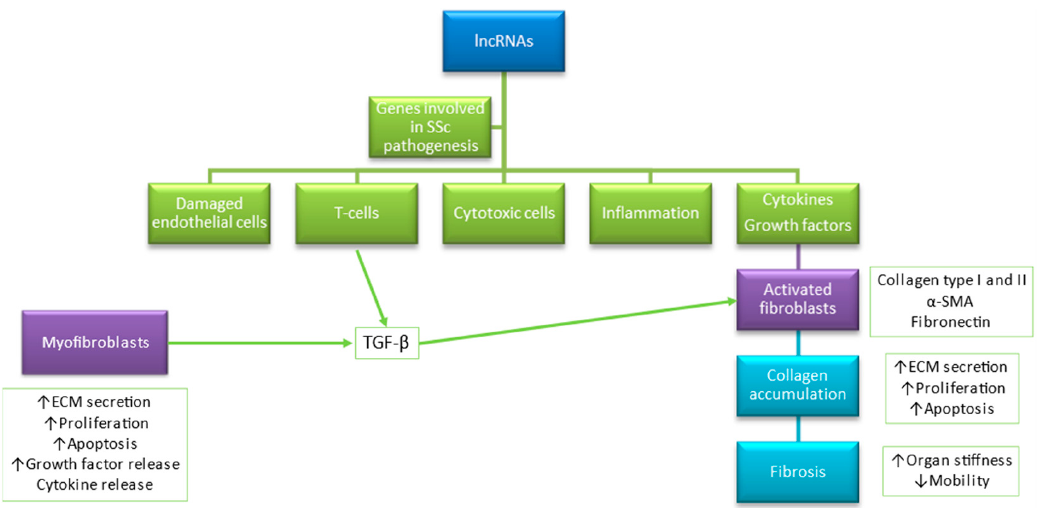
Figure 2. Accumulating evidence shows that lncRNAs play a role in modulation genes related to endothelial function, immunity, inflammation, and cytotoxicity. Based on [15,75].